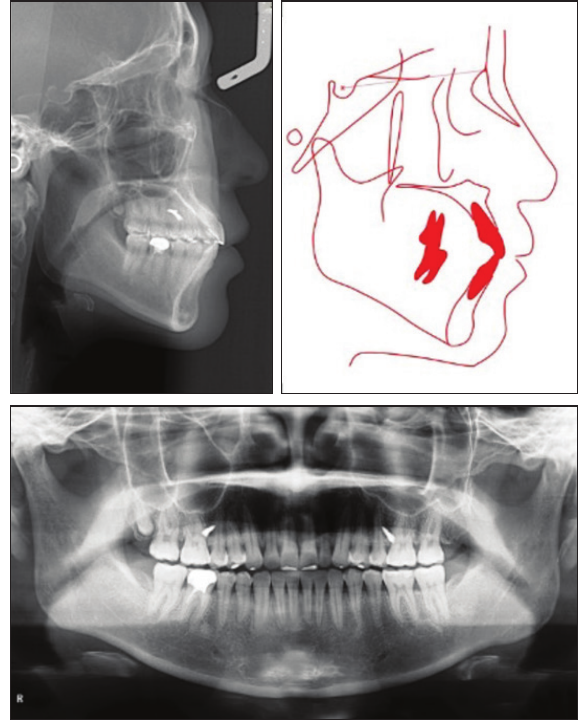
Figure 9. Post-treatment cephalometric radiograph (top left) and tracing (top right) and panoramic radiograph (bottom).